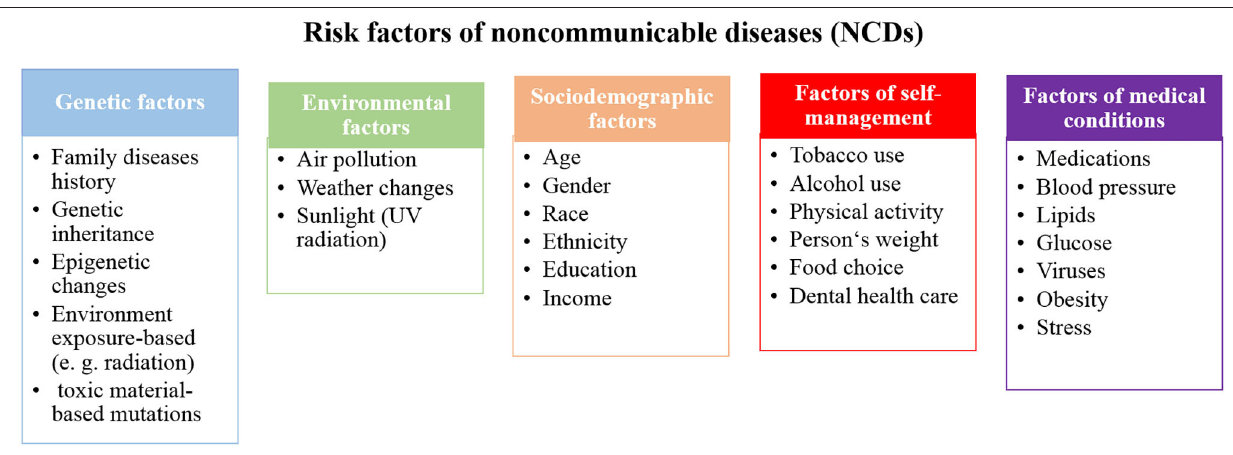
FIGURE 2 | A proposed model to classify the risk factors of